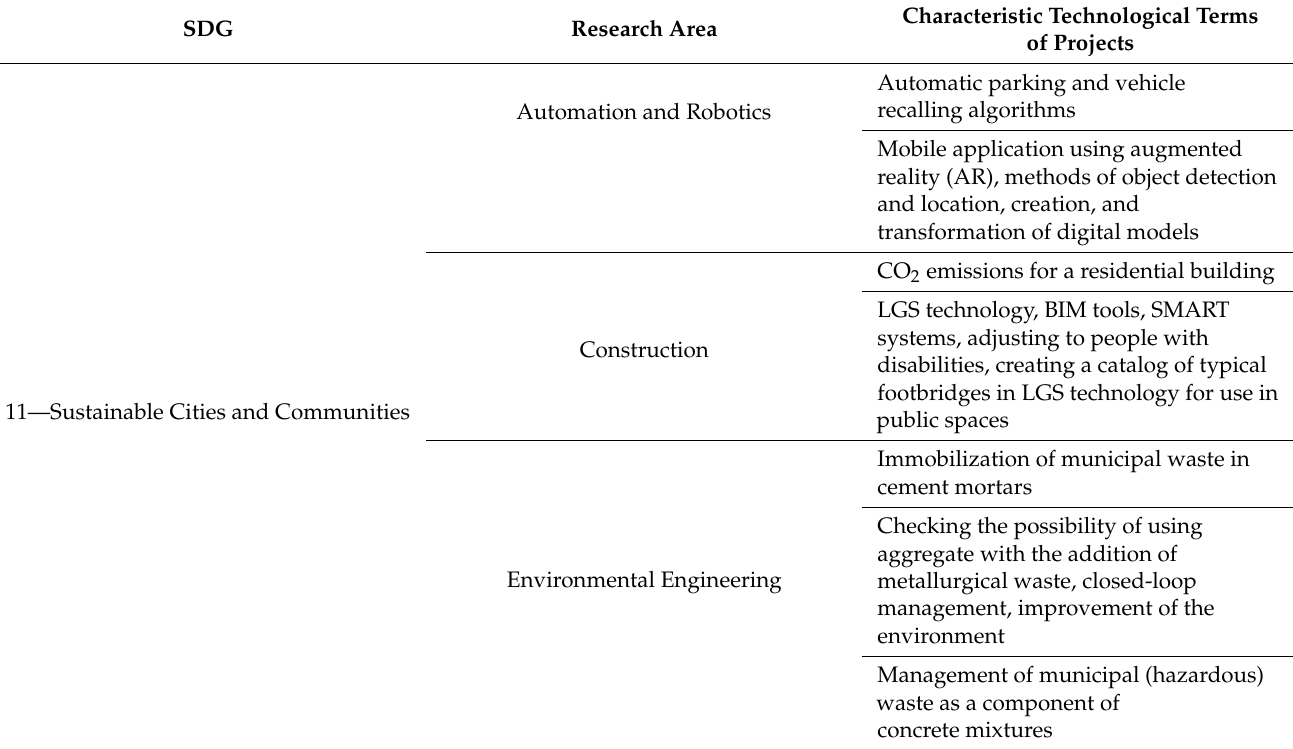
Table 10. Characteristic technological terms of projects for Sustainable Cities and Communities. SDG